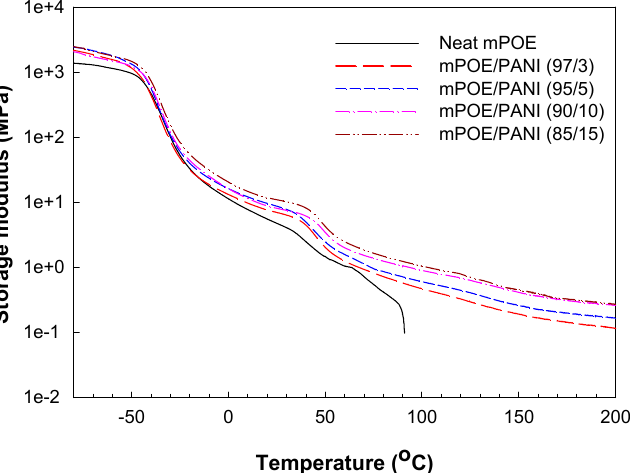
Figure 3. Variation in storage modulus (E ′ ) with temperature for neat mPOE and mPOE/PANI blends.